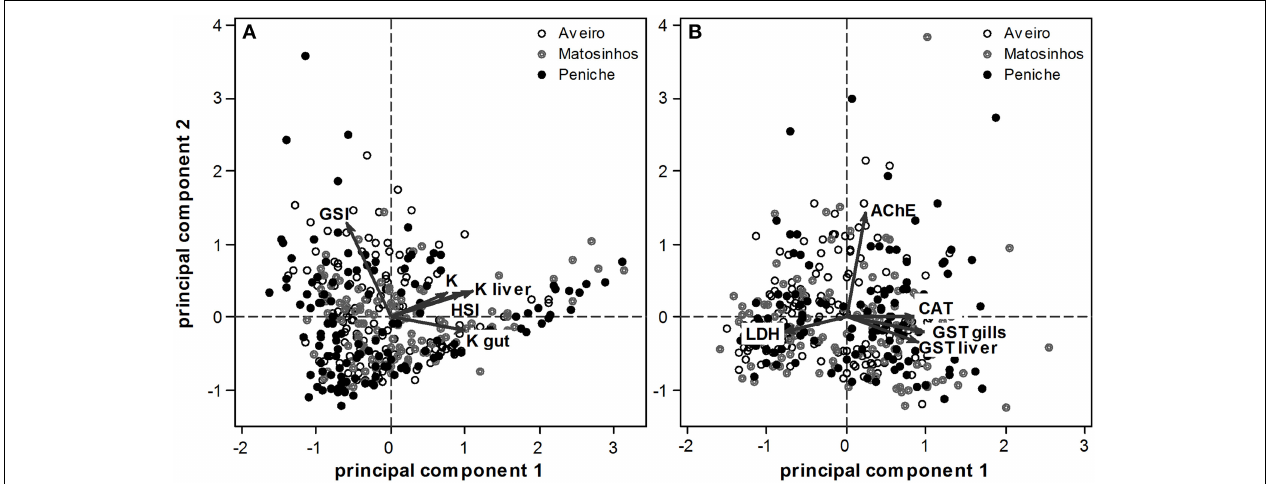
biomarker profile (B). Dots depict individual fish (from different subpopulations) and arrows represent physiological and biochemical gradients.